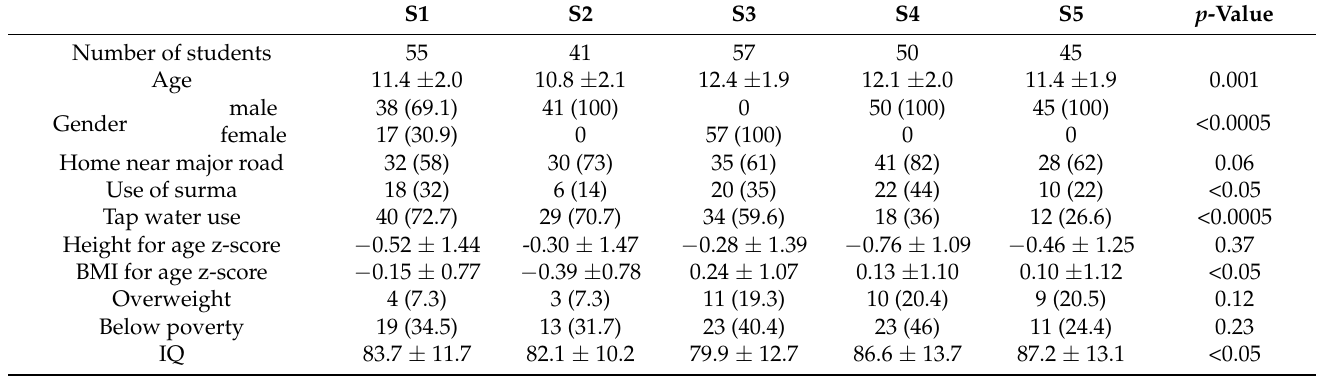
Table 1. Results from sample description with children ’ s predictors in each school. Data are means ± standard deviation, or n (percentage). Overweight: BMI for age z-score > 2 standard deviations.